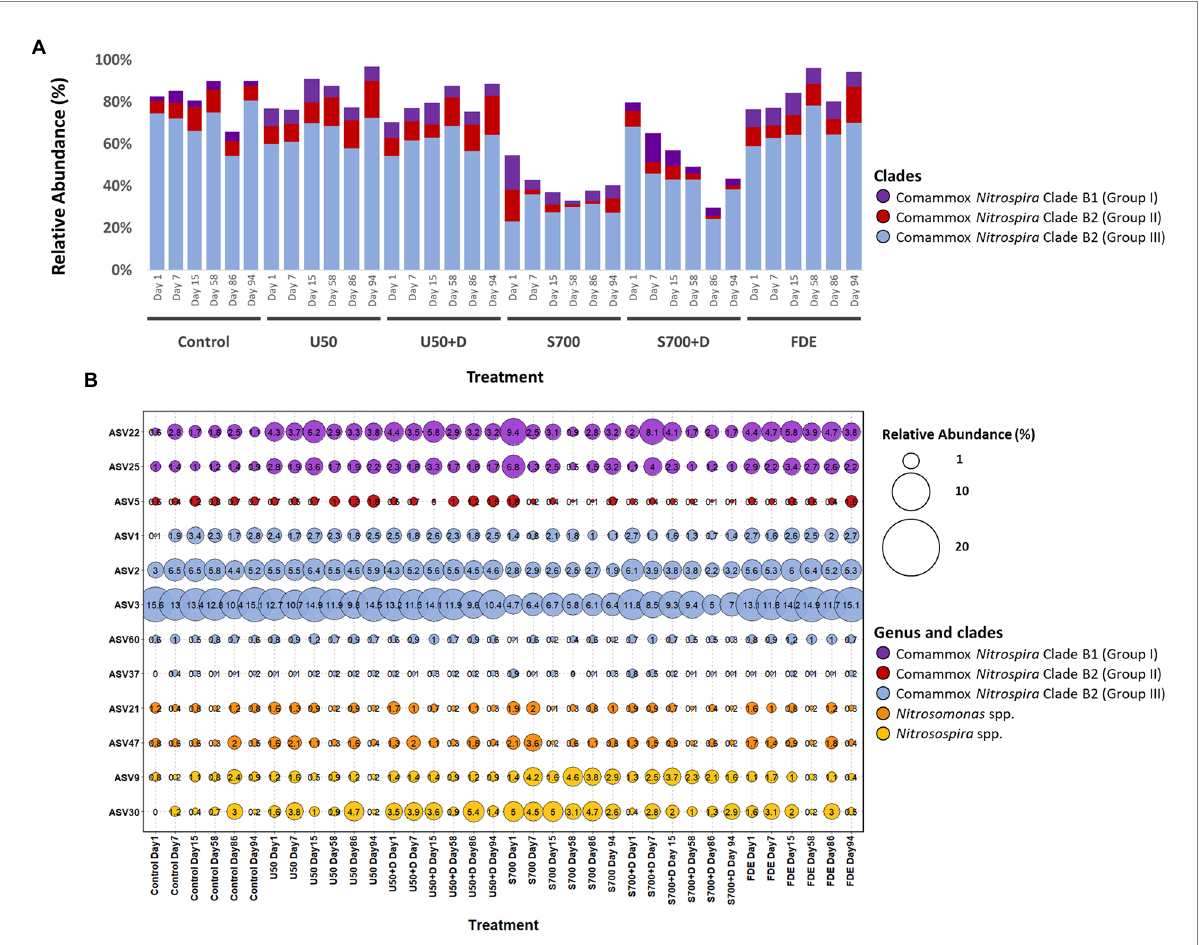
FIGURE 6 Relative abundance of ammonia oxidizers based on high-throughput sequencing of the amoA gene. (A) Relative abundance of the total comammox Nitrospira Clade B1 (Group I – purple), Clade B2 (Group II – red) and Clade B2 (Group III – blue) of each treatment at Day 1, 7, 15, 58, 86, and 94. (B) Relative abundance (percentage in proportion) of selected ASVs of Nitrosospira spp., Nitrosomonas spp., and comammox Nitrospira Clade B1 and